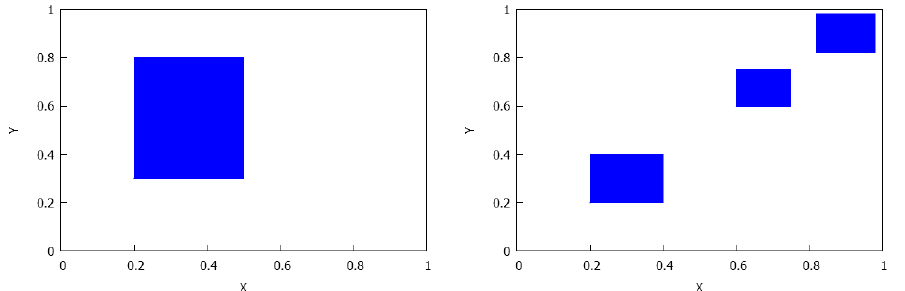
Figure 16. Case (i.O) corresponding to (cid:96) = 1 and (cid:96) = 3, whenever f 1 ( A ) ∩ Int ( B ) (cid:54) = ∅ , A and B no